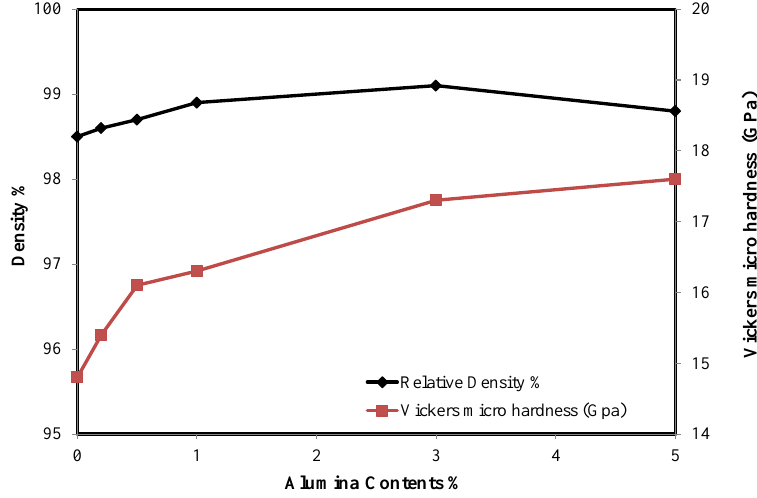
Figure 6. The sintered density and micro hardness of YSZ/Al 2 O 3 composite as a function of alumina content.